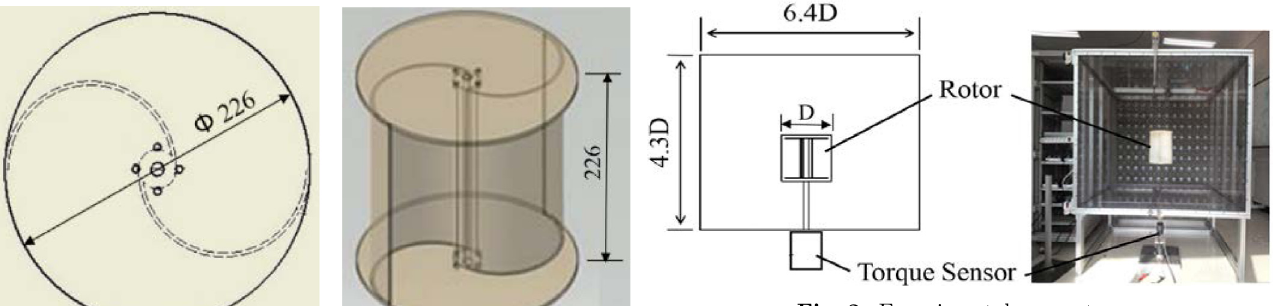
Fig. 1. Con fi guration of scaled-down Savonius turbine